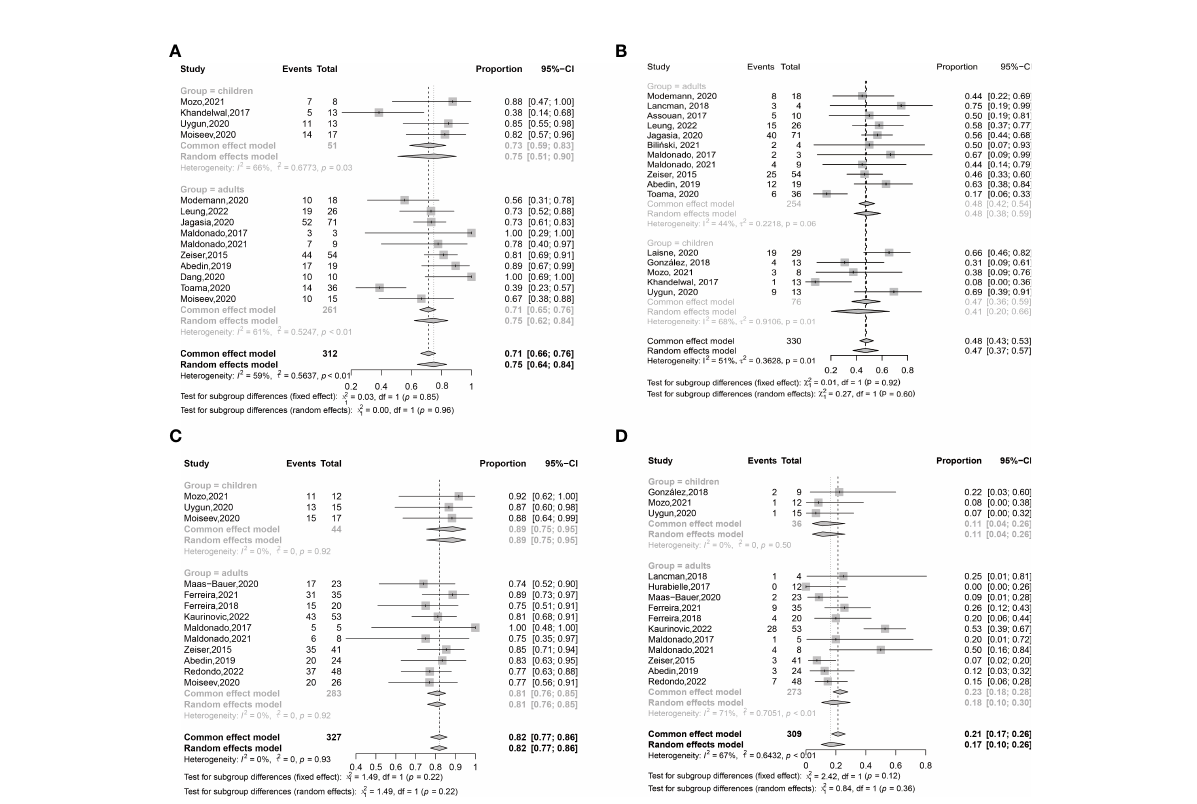
FIGURE 3 The subgroup analysis of adults and children in ORRs (A) and CRRs (B) at any time after ruxolitinib treatment in SR-aGVHD; The subgroup analysis of adults and children in ORRs (C) and CRRs (D) at any time after ruxolitinib treatment in